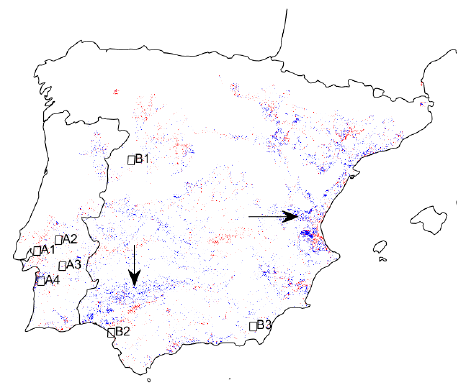
Figure 6. Areas identified as C7 or C8 and where WTD is lower than (red) and higher than (blue) 20 m. The arrows point to two regions of high altitude where WTD is higher than 20 m: Sierra Morena, in the South, and the province of Valencia, in the East. The boxes correspond to the Locations listed in Table 2. The labels of the boxes are also listed in Table 2.